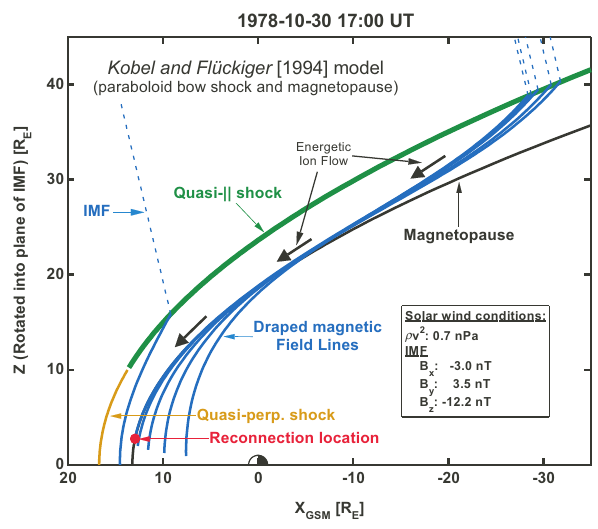
Fig. 3. Schematic illustration of the IMF convecting into the mag- netosheath for conditions near 17:00UT. Field lines convecting through the magnetosheath thread the quasi-parallel bow shock re- gion. In this region, ions are ubiquitously accelerated up to ener- gies of ∼ 150keV/e. As the field line drapes against the magne- topause, it reconnects at the low latitude reconnection site. Thermal plasma and energetic ions on the field line undergo acceleration at the reconnection site, propagate to the ionosphere, and return to high latitudes. The reconnected field line convects to high latitudes, where the thermal and energetic ion populations were observed by the ISEE-1